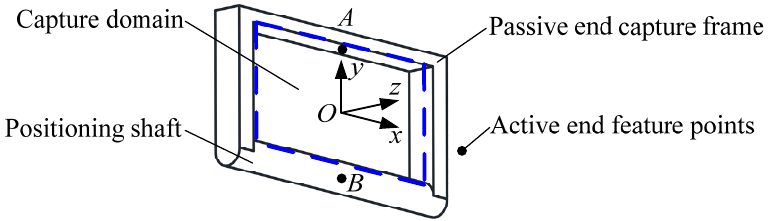
Figure 7. Capture frame configuration. ( A : The top plate center of capture frame; B : The positioning shaft center of capture frame.)